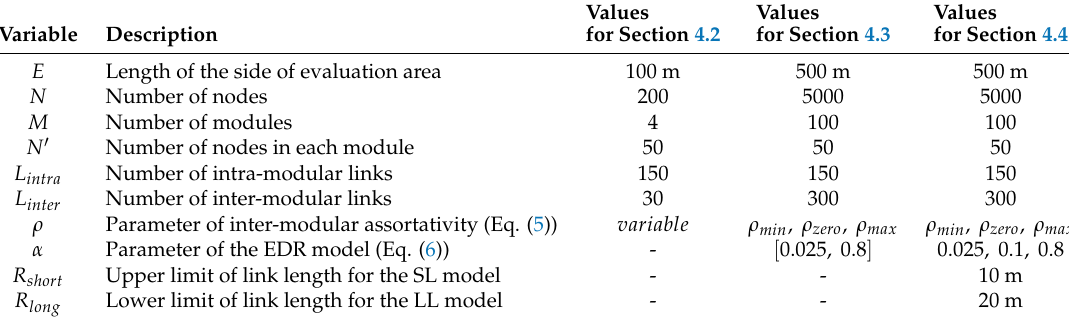
Table 1. Parameter